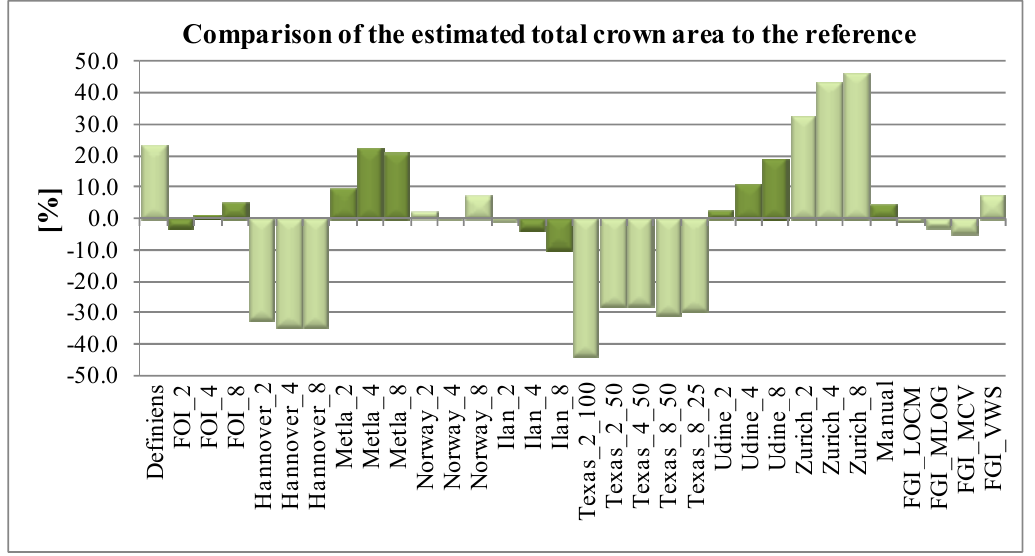
Figure 11. Total crown area